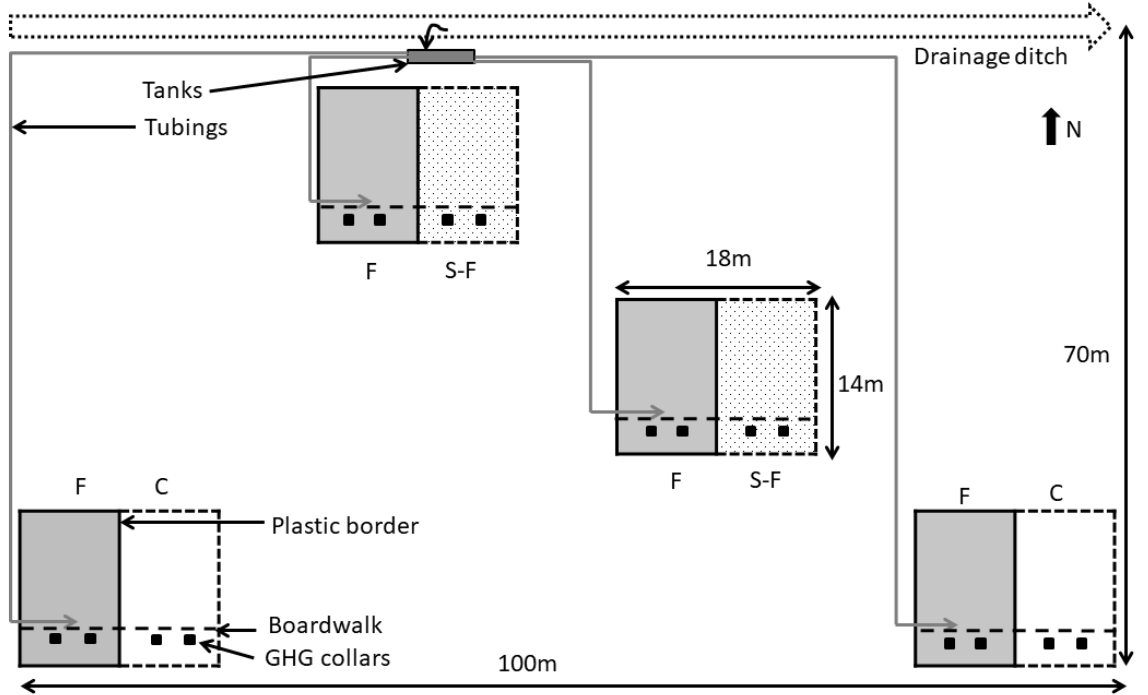
Figure 1. Layout of the field experiment. Four blocks (14 × 18 m) were divided into two plots (14 × 9 m) to impose flooding treatments. The water table treatments were flooded (F), semi-flooded (S-F), and control (C). Water was pumped from the drainage ditch (large dotted arrow) to the tank. The grey arrows indicate pipelines connecting water tanks to the flooded plots confined by plastic borders. Black squares at the southern end of each plot indicate the collars (0.55 × 0.55 m) installed for gas flux measurements.